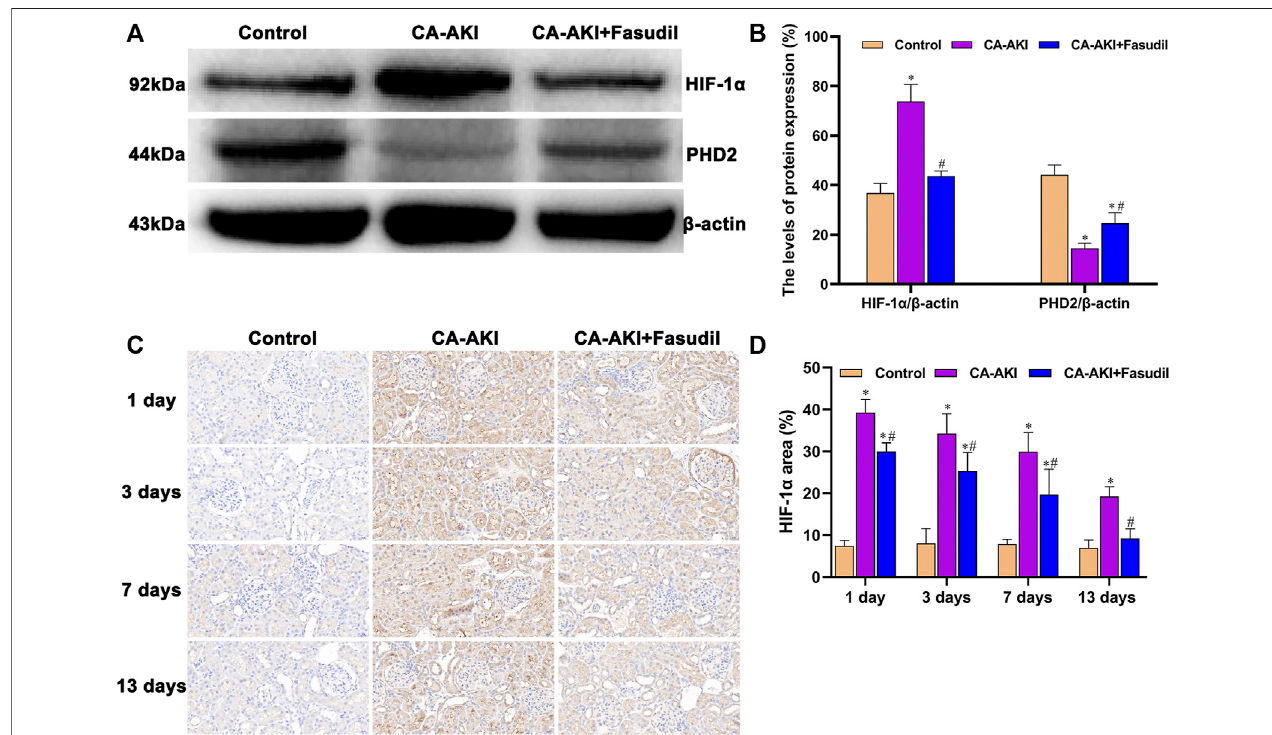
FIGURE9| HIF-1 α /PHD2expressioninthreeanimalgroups: (A) expressionlevelsofHIF-1 α andPHD2bygroup(westernblot); (B) relativedensitometryanalysisof proteinratios; (C) HIF-1 α expression bygroup;and (D) HIF-1 α scoresbygroup.* p < 0.05betweenCA-AKI/CA-AKI+Fasudil and controls; # p < 0.05betweenCA-AKI + Fasudil and CA-AKI.